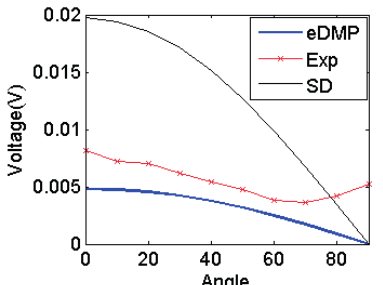
Figure 14. Simulation results